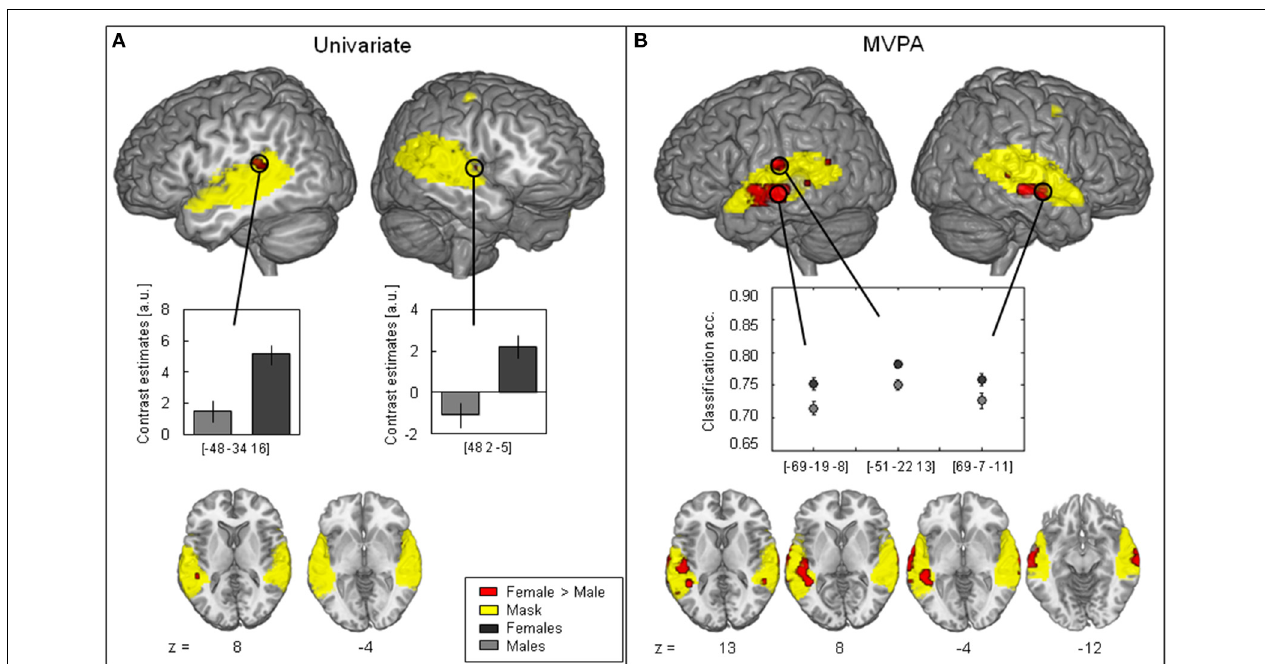
FIGURE 2 | Contrast between female > male (red). (A) Univariate analysis showing significant female > male difference (two-sample t -test, FWE-corrected, p < 0 . 05) in the left posterior part of the superior temporal gyrus (STG) and the right anterior STG. Contrast estimates at peak voxel showing stronger activation in females (black) as compared to males (gray) in response to vocal vs. non-vocal sounds. (B) MVPA showing significant classification accuracy above chance level in the right middle part of the